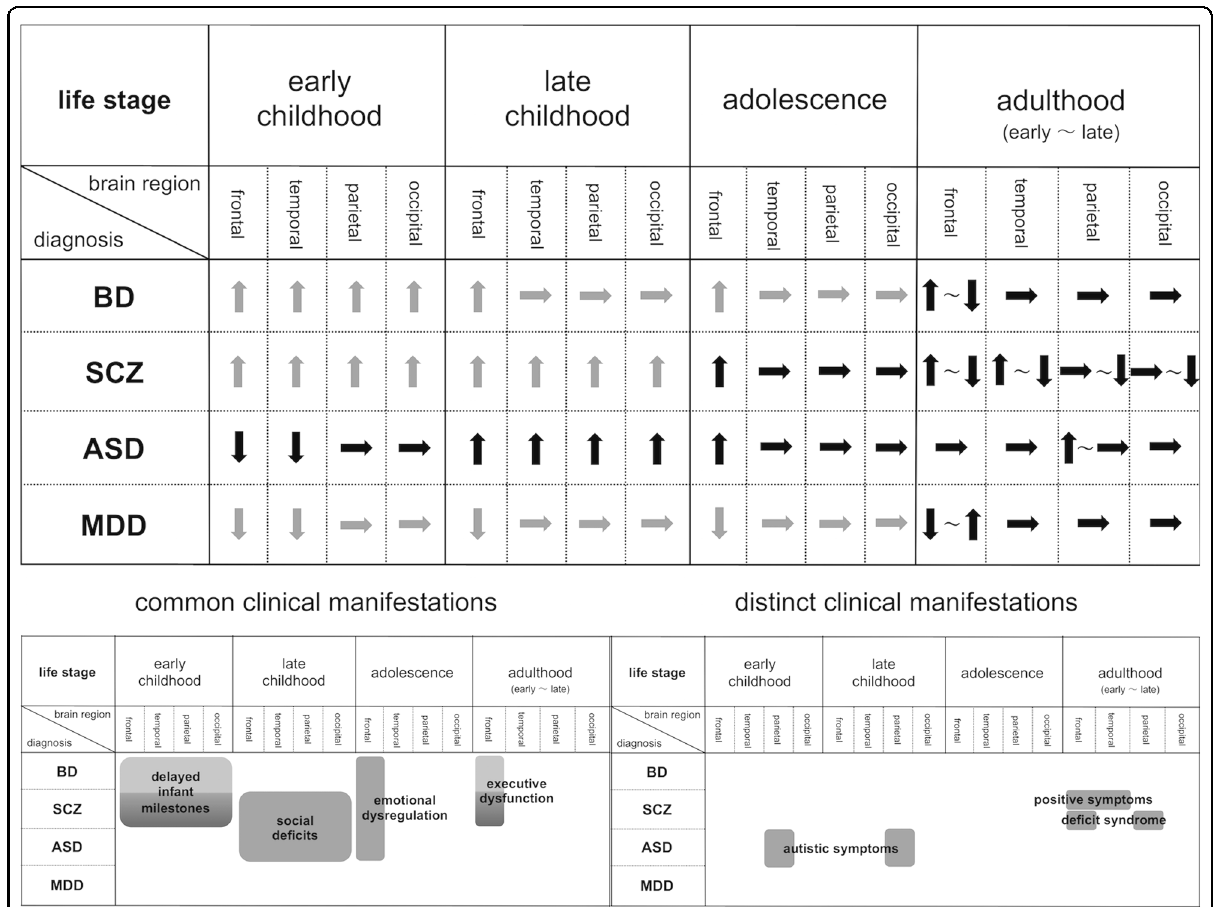
Fig. 4 Overarching model that spans the diagnoses. Upper: The gyri fi cation fi ndings in patients with major psychiatric disorders at varying stages of life compared with healthy controls. Gray arrow: Presumed direction of gyral pattern changes suggested from fi ndings reported in neighboring developmental periods and other indicators (e.g., gene expression, gray matter volume, and white mater integrity); Black arrow: Dominant direction of gyral pattern changes based on previous gyral fi ndings being weighted according to the number of studies, sample size for studies, representativeness of cases, and methodological advantage to assess gyral patterns. Below: Concept maps showing common or distinct clinical manifestations mapped onto deviated gyri fi cation patterns across psychiatric disorders. ASD autism spectrum disorder, BD bipolar disorder, MDD major depressive disorder, SCZ